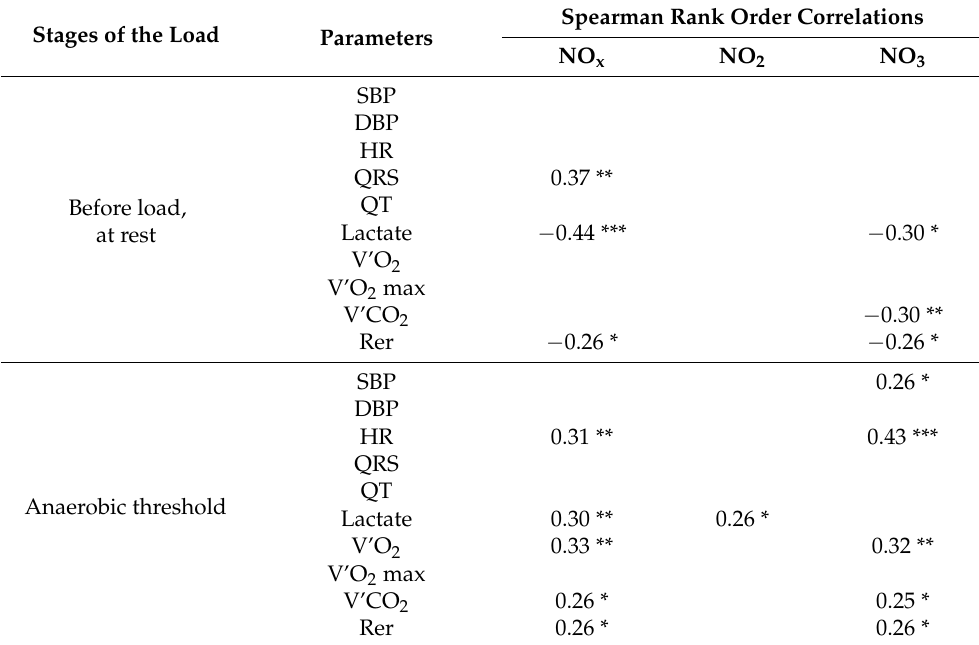
Table 5. Correlations between biochemical and cardiorespiratory parameters at different stages of cross-country skiers in Group